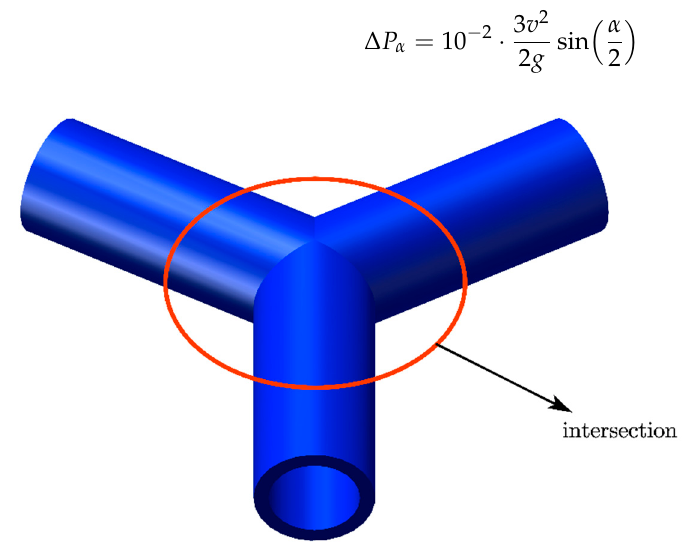
Figure 5. Schematic diagram of intersection.